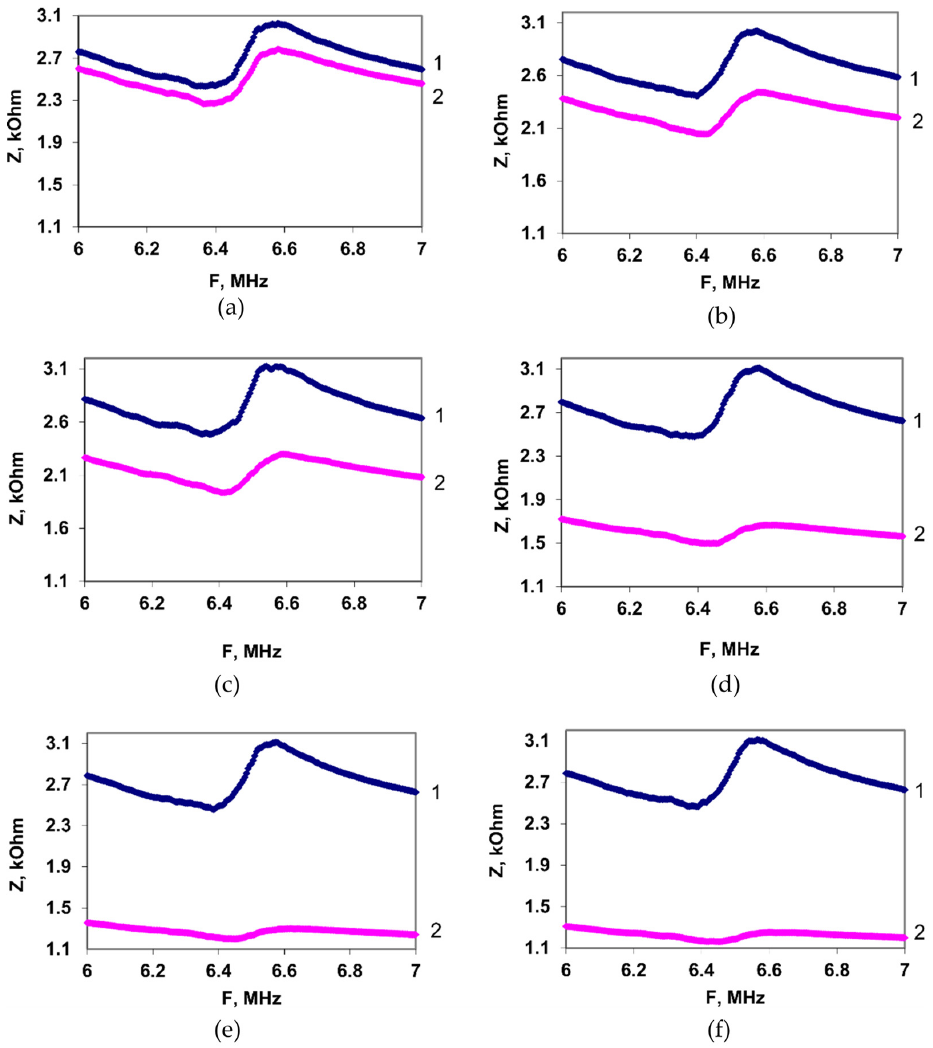
Figure 4. The dependences of the electrical impedance modulus Z on the frequency for a suspension of E. coli K-12 cells before (curve 1) and after (curve 2) the addition of the chloramphenicol with the concentration ( μ g/mL): ( a )—0.5; ( b )—2.5; ( c )—5; ( d )—10; ( e )—12; ( f )—15.